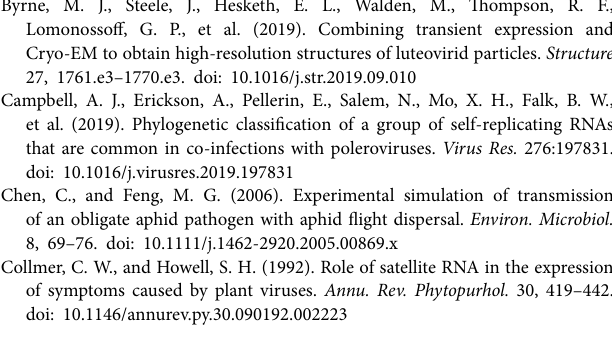
Supplementary Figure 1 | Symptoms on the tobacco K326 plants inoculated with TBTV-YK, TVDV-YK, TBTVsatRNA-YK, and TVDVaRNA-YK. The plants were photographed at 101 days postinoculation. The plant agro-infiltrated with pCB301 (an empty expression vector) was used as a control. Supplementary Figure 2 | Phenotypes of Nicotiana benthamiana plants inoculated with TVDV-YK, TBTV-YK, TBTVsatRNA-YK, and TVDVaRNA-YK at 16 dpi, 42 dpi, and 74 dpi, respectively. Supplementary Figure 3 | Symptoms on the tobacco plants inoculated with TBTV-YK. (A) The top view of tobacco K326 plants inoculated with TBTV-YK, arrows indicate necrotic spots in the systemic leaves. (B) The side view of tobacco K326 plants inoculated with TBTV-YK, rectangular dashed box indicate shorter internodes. The plants were photographed at 45 days postinoculation both in (A,B) . (C) Phenotypes of Nicotiana benthamiana plants inoculated with pCB301 and TBTV-YK at 74 dpi, respectively.